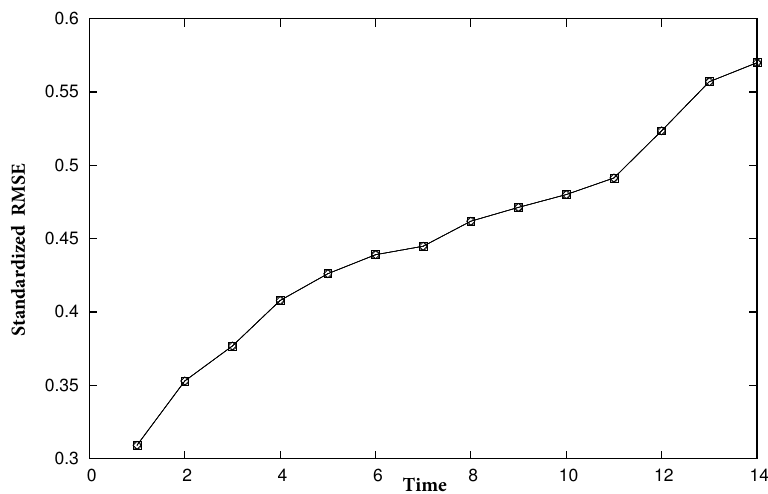
Figure 14. Prediction errors for coop3 using nonlinear